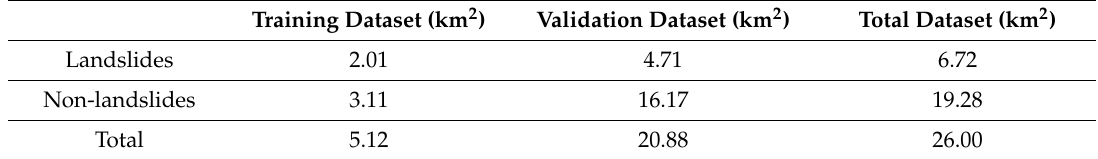
Table 1. Training and validation